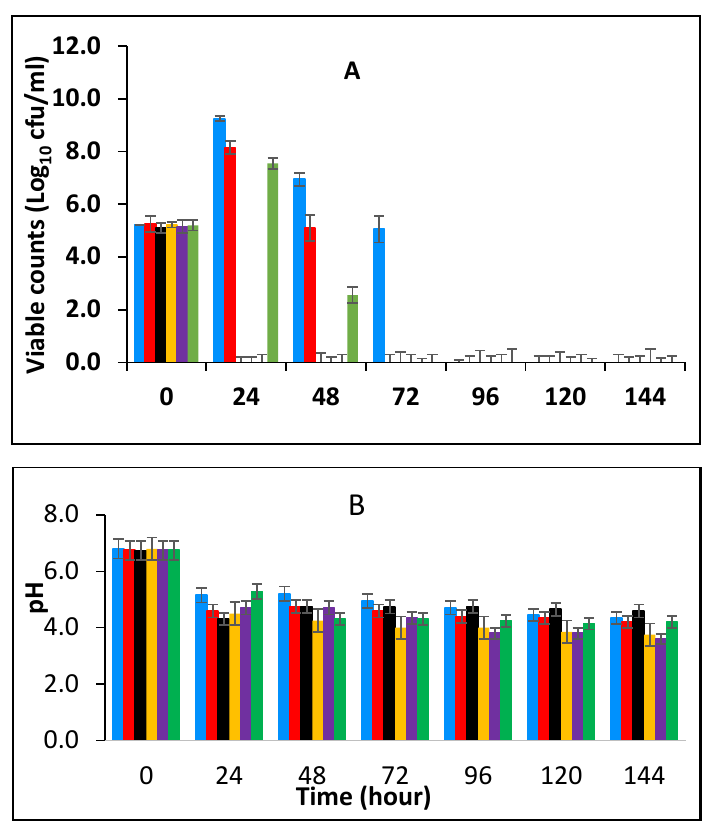
Figure 4. Survival of E. fergusonii ( A ) and change in pH ( B ) during storage at 25 °C of milk fermented at 43 °C , in the presence of essential oils of black pepper (BPE) and cinnamon extracts (CE) at different concentrations for 24 h. Concentrations are in % ( w / v ), values are the mean of three individual replicates (means ± SD). Control [ ] ; 0.5% BPE alone [ ◼ ] ; 0.1875% CE + 0.125% BPE [ ◼ ]; 0.125% CE + 0.25% BPE [ ◼ ]; 0.0625% CE + 0.375% BPE [ ◼ ]; 0.25% CE alone [ ◼ ].